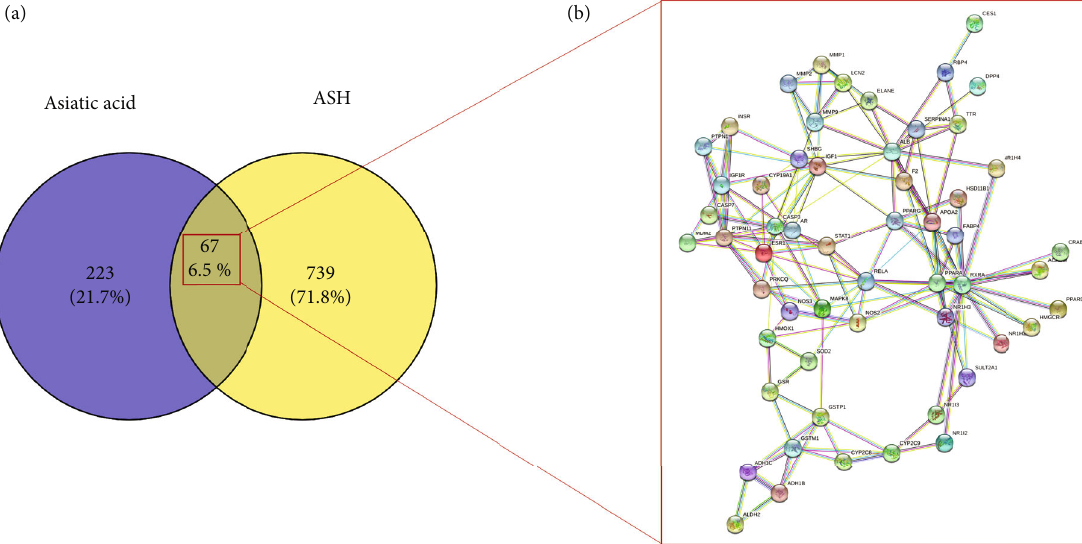
Figure 2: (a) Venn diagram of intersection of asiatic acid and ash targets. (b) Protein interaction network of intersection targets.